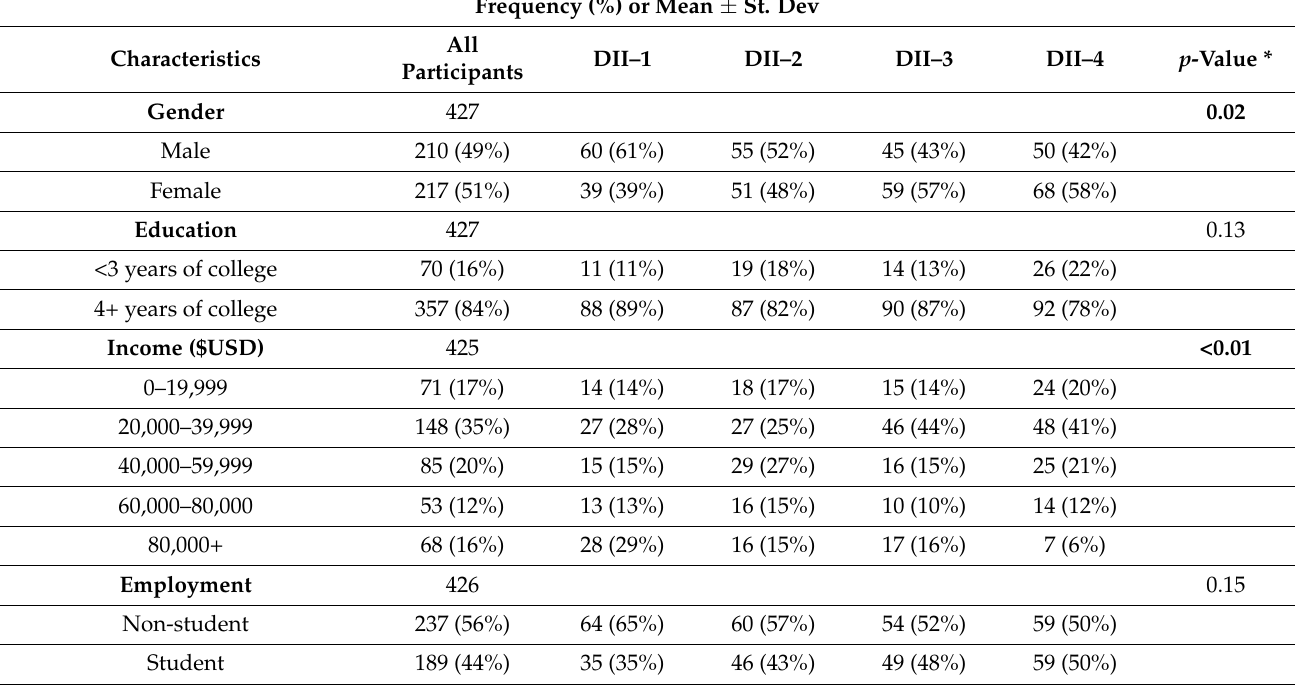
Table 1. Baseline population characteristics overall and by Dietary Inflammatory Index categories among all participants of the Energy Balance